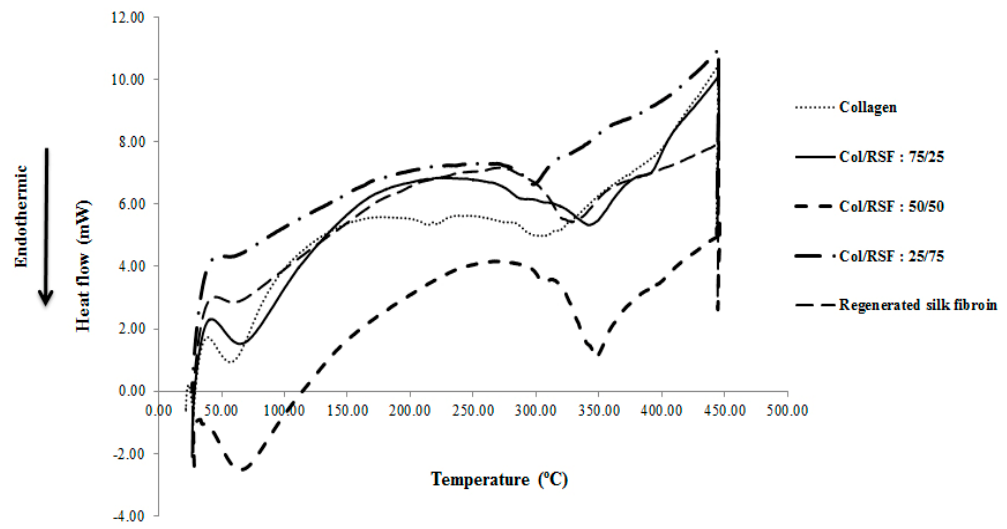
Figure 5. DSC curve of collagen/RSF blend films.